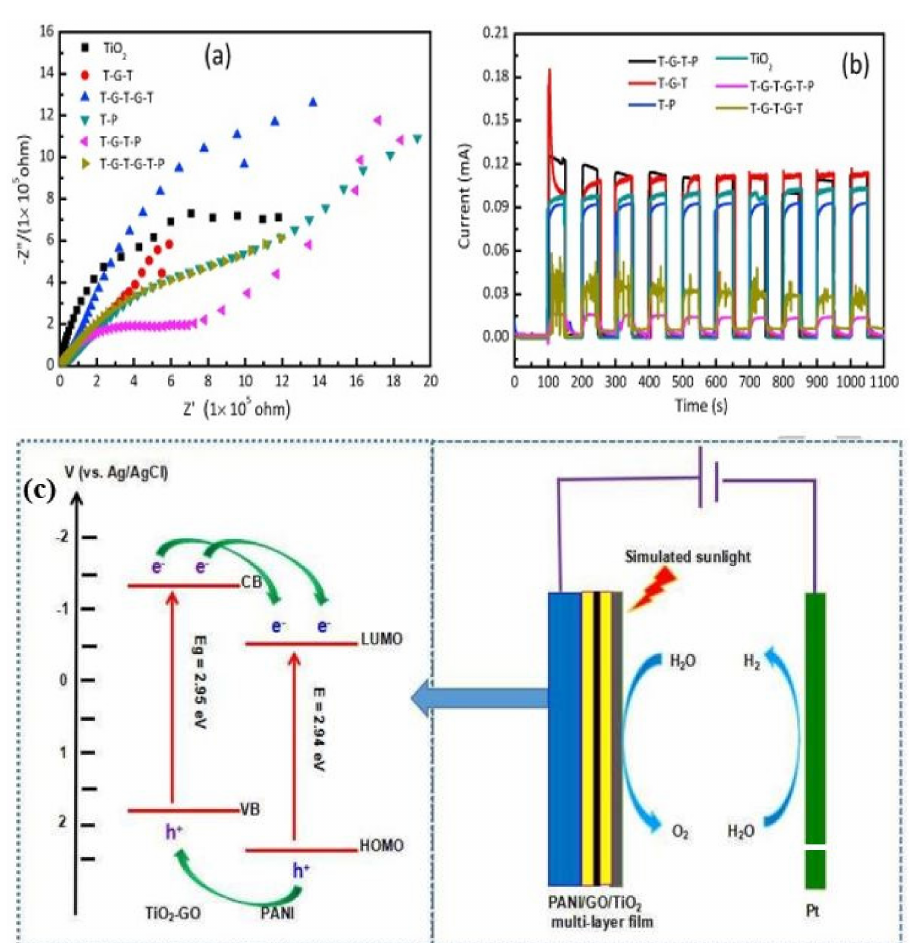
Figure 19. ( a ) EIS spectra of TiO 2 , GO/TiO 2 , PANI/TiO 2 and PANI/GO/TiO 2 hybrid films electrodes. The frequency range of 100 kHz-0.01 Hz, an amplitude of 10 mV at an applied potential of +0.6 V, the electrolyte was of 0.42 mol L − 1 NaCl, 0.055 mol L − 1 MgCl 2 and 0.029 mol L − 1 Na 2 SO 4 . ( b ) The photocurrent response of hybrid film electrodes. The potential of the working electrode was set as 0.6 V vs. Ag/AgCl/3M KCl. ( c ) Sketching map of energy band structure, charge separation and PEC hydrogen generation mechanism for ternary PANI/GO/TiO 2 film electrode. (Reprinted with permission from reference [205]. Copyright 2018,